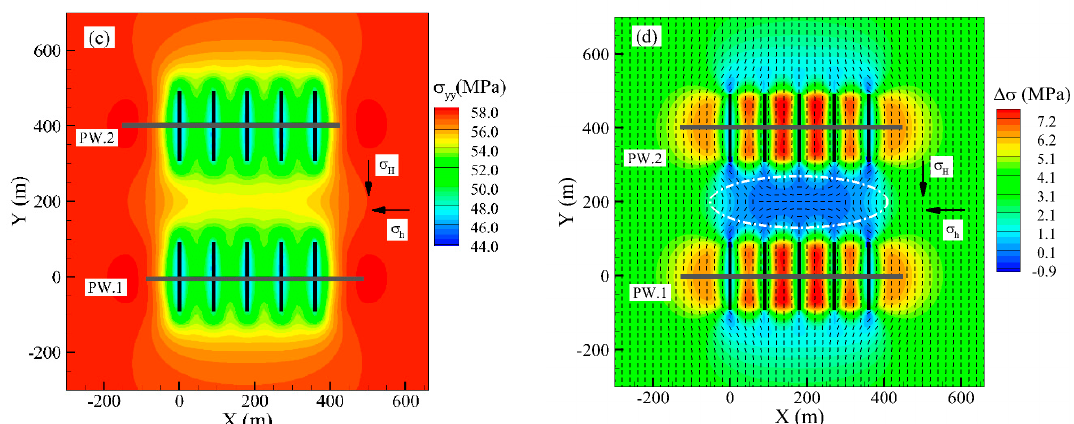
Figure 14. Reservoir pore pressure and total stresses distribution in a horizontal cross-section in the central XY-plane after 2 years of production: ( a ) The reservoir pore pressure distribution (dotted black lines are trajectories of the local maximum principal stress), ( b ) horizontal stress component σ xx , ( c ) horizontal stress component σ yy , ( d ) distribution of the horizontal stress contrast. Negative values of the stress contrast show stress reversal zones (dark blue regions in part d ).